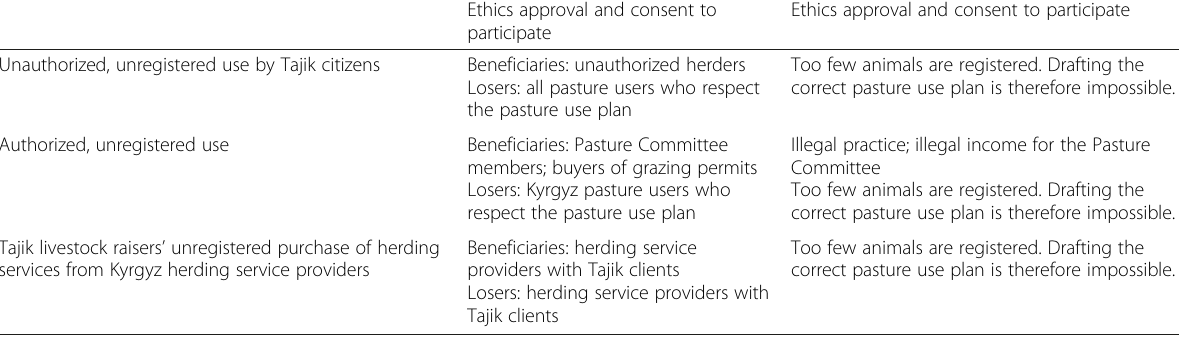
Table 4 Distribution of benefits and sustainability impact of property rights institutions in